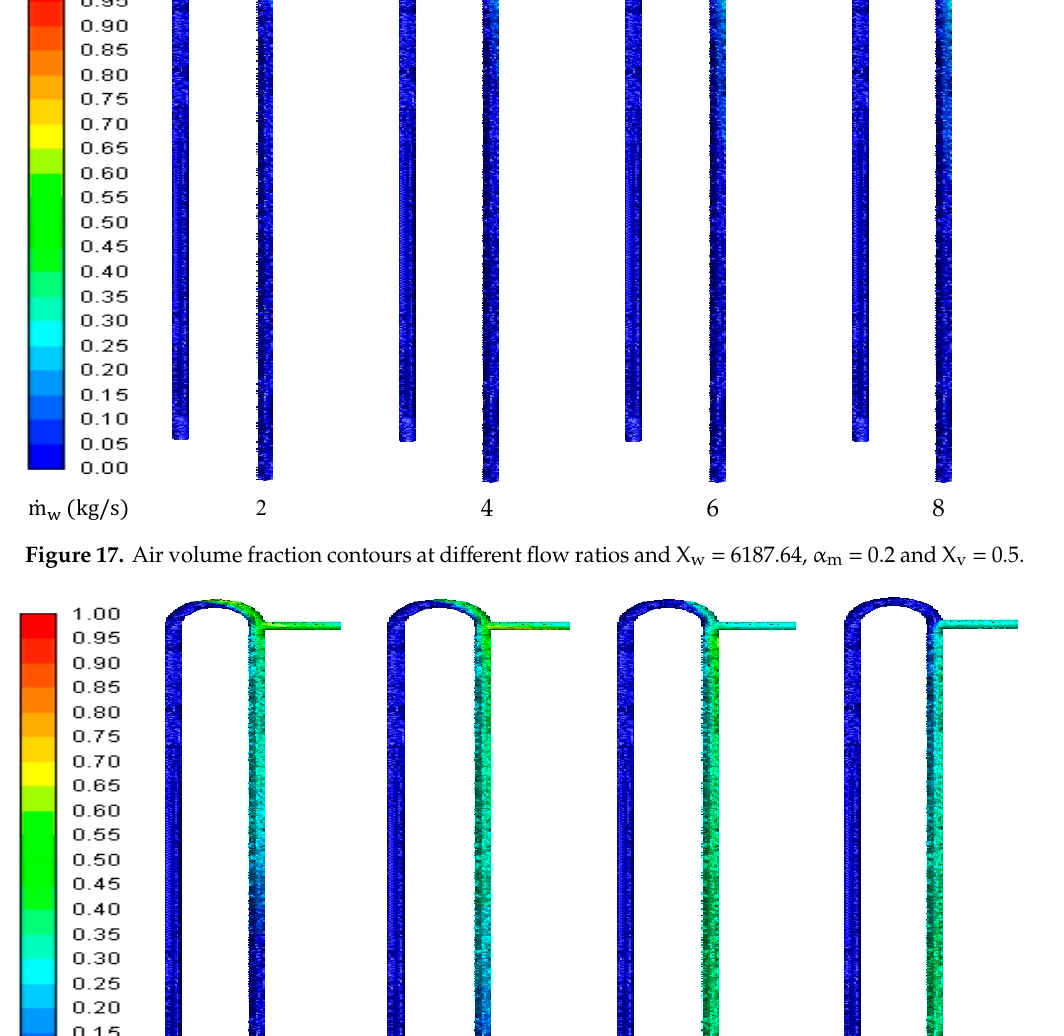
= 662.96, α = 0.7 and X = w m v